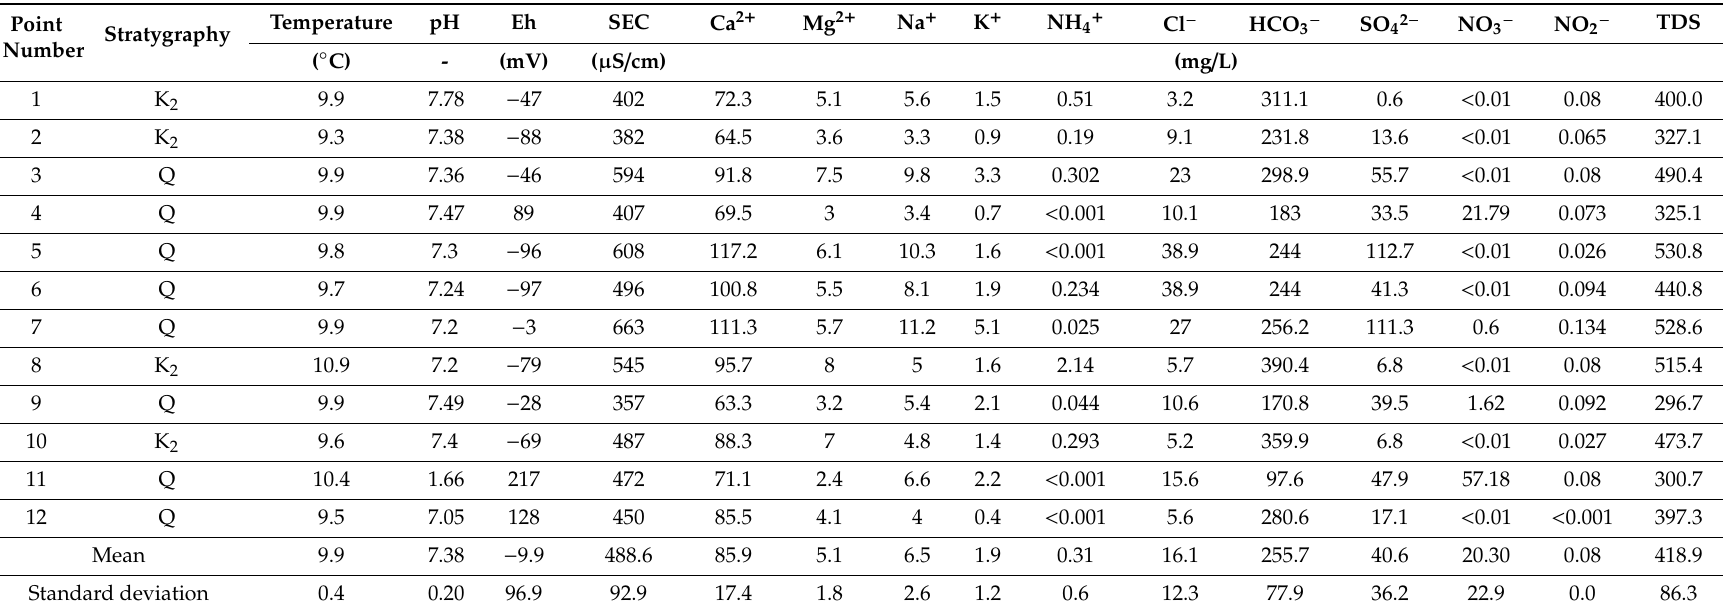
Table 1. Chemical composition of the analysed